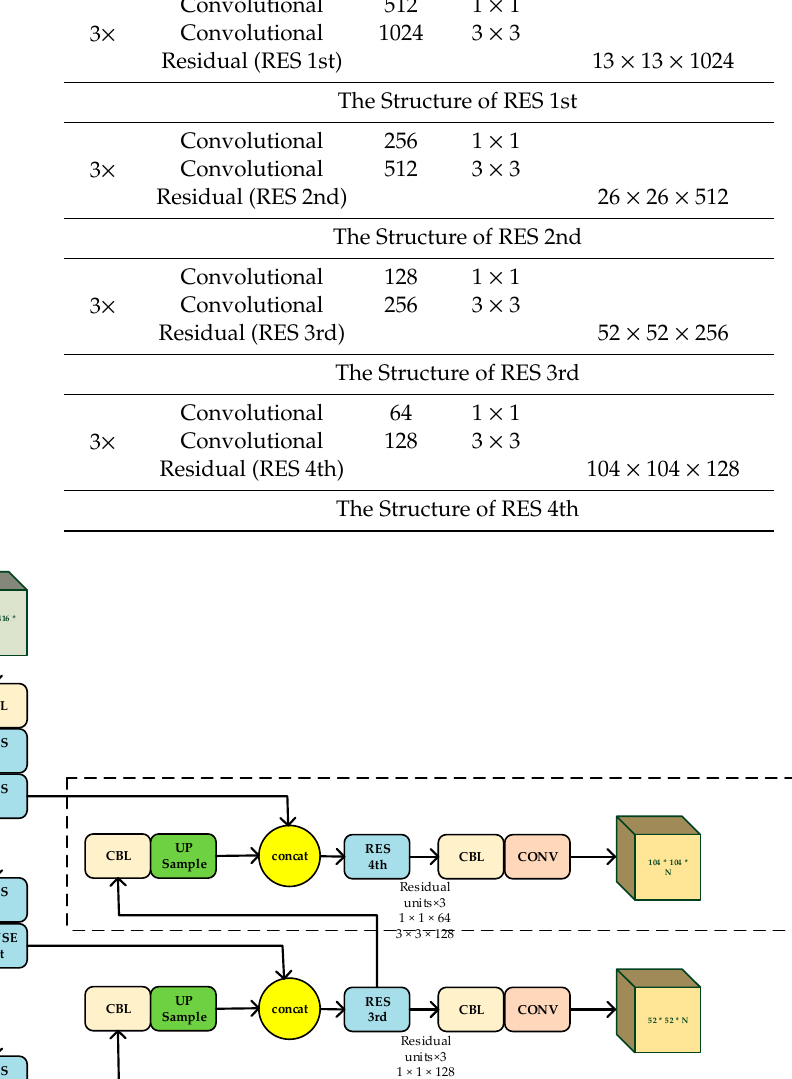
Table 3. The structure of residual units.